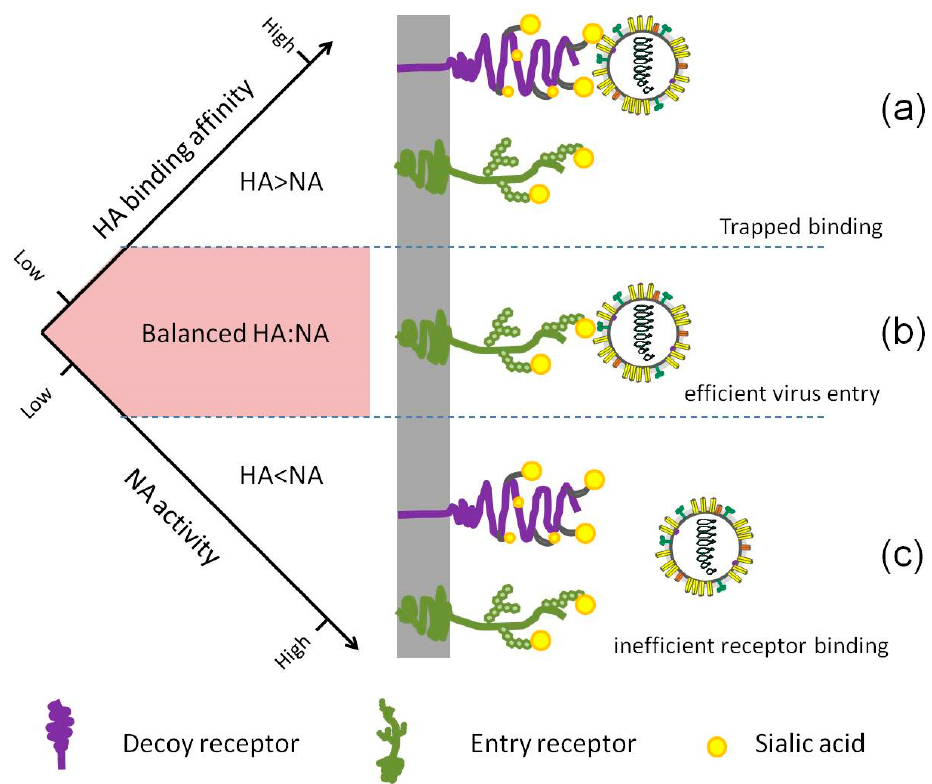
Figure 3. The relative HA binding affinity and NA activity need to be balanced for efficient entry. ( a ) If the HA and NA are mismatched and the NA activity is suboptimal, the virus may remain bound to decoy receptors, blocking virus movement and entry. ( b ) Efficient cleavage of SA from decoy receptors by NA enables HA access to the right entry receptors, followed by efficient endocytosis. (c) In the case that NA activity is too strong when compared to HA binding affinity, every binding attempt of the virus via HA will be disrupted by NA cleavage, resulting in failed binding.